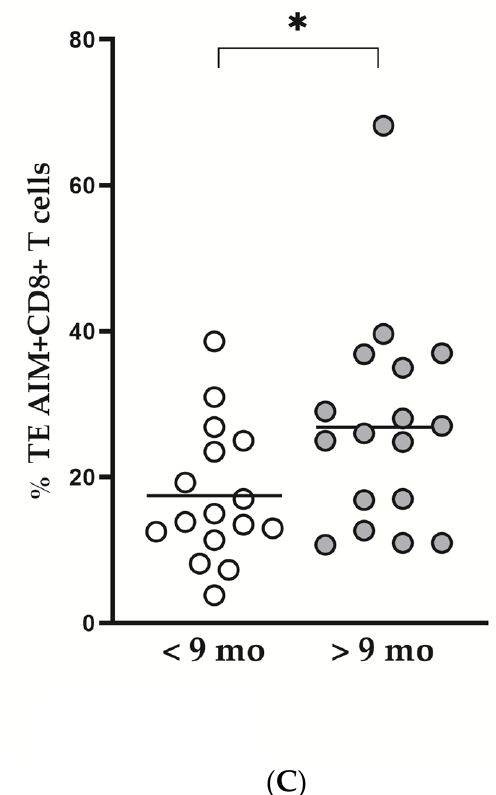
Figure 3. Comparison between the differentiation profiles (relative shares of naïve, CM, EM, and TE) among the S1–specific T cell pools. ( A ) Gating strategy After detection of AIM+ (CD69+CD137+ and/or CD154+) CD4+ and CD8+T cells, as explained in Figure 2, the shares of naïve (CD45RA+CD197+), CM(CD45RA-CD197+), EM(CD45RA-CD197-), TE(CD45RA+CD197-) were de- termined within gated AIM+CD4+ or AIM+CD8+ T cells. ( B ) Relative shares (mean values) of naïve, CM, EM, and TE cells among AIM+CD4+ (upper panel) and AIM+CD8+ (lower panel) S1-specific T- cell pool in samples < 9 mo (left side) and > 9 mo PSO (right side). ( C ) Individual values for the share of TE cells among AIM+CD8+ T in samples <9 mo and >9 mo PSO. Statistical differences were eval- uated by non-paired t -test .